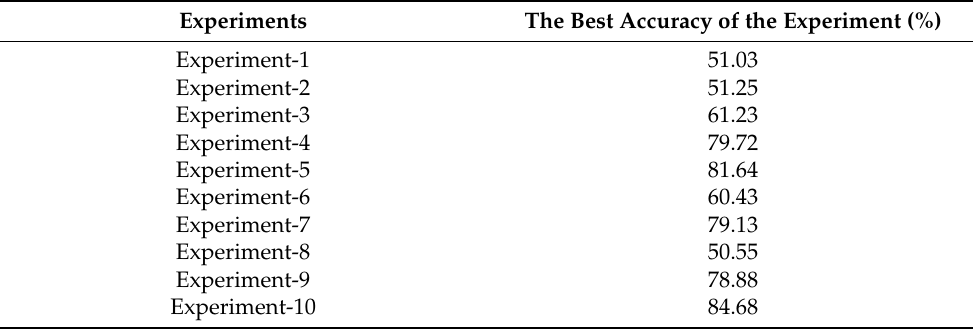
Table A2. Results of the model with different optimization algorithms on the test dataset.